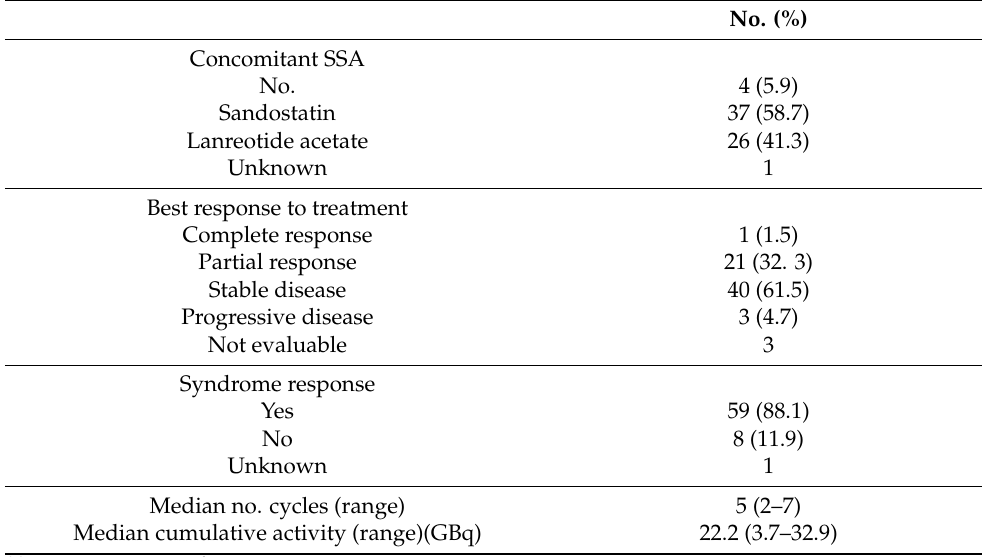
Table 2. Treatment characteristics of F-NET patients treated with 177 Lu-PRRT.